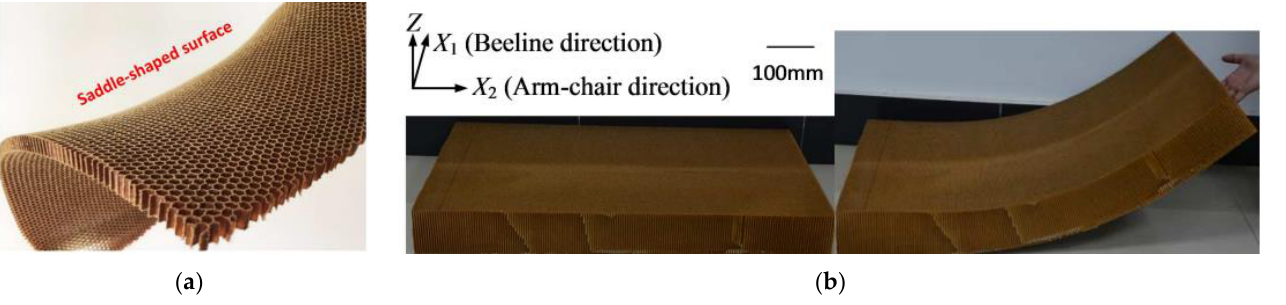
Figure 1. ( a ) Saddle-shaped surface of bent hexagonal honeycomb panel; ( b ) bendable aramid over- expanded honeycomb [14]. over-expanded honeycomb